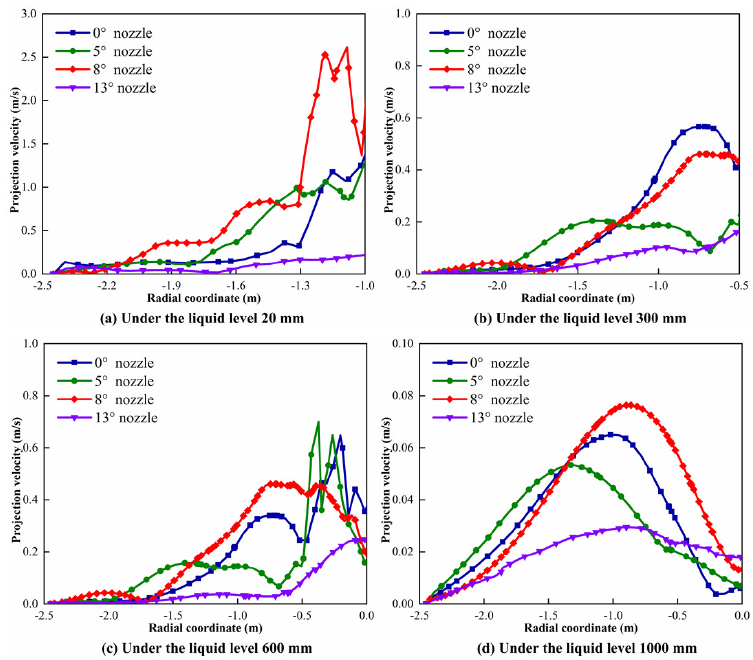
Figure 11. Molten steel movement in various heights with different multi-nozzle oxygen lances. ( a ) Under a liquid level of 20 mm. ( b ) Under a liquid level of 300 mm. ( c ) Under a liquid level of 600 mm. ( d ) Under a liquid level of 1000